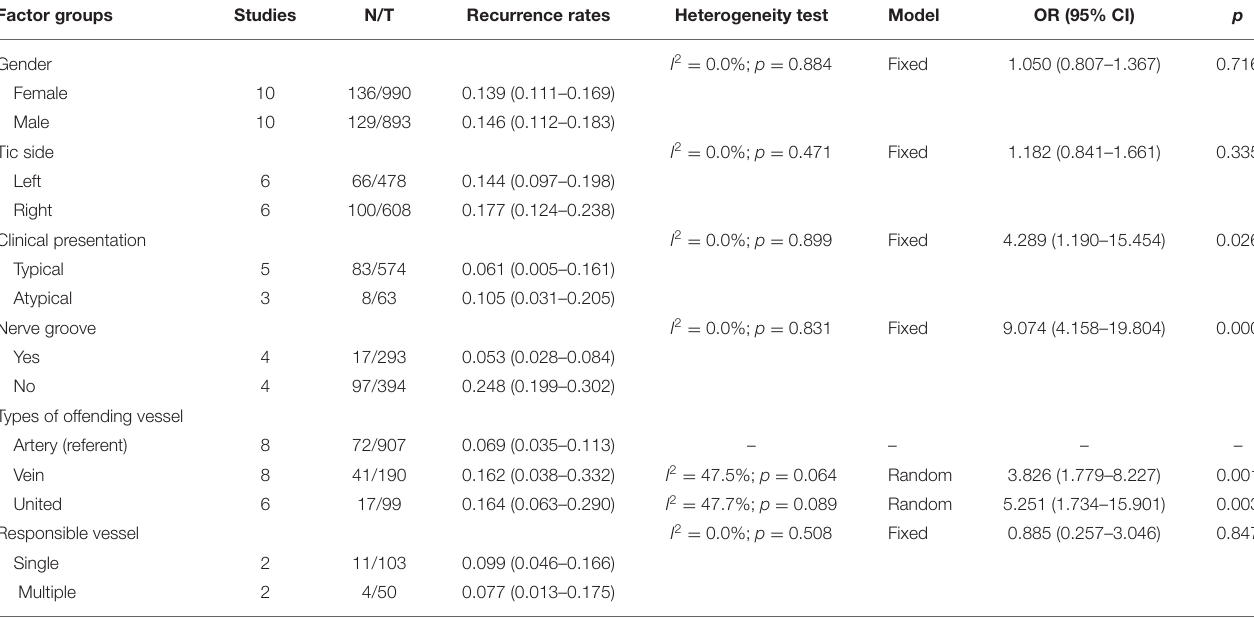
TABLE 1 | Analysis of factors affecting the recurrence rates after microvascular decompression in the treatment of primary trigeminal neuralgia. Factor